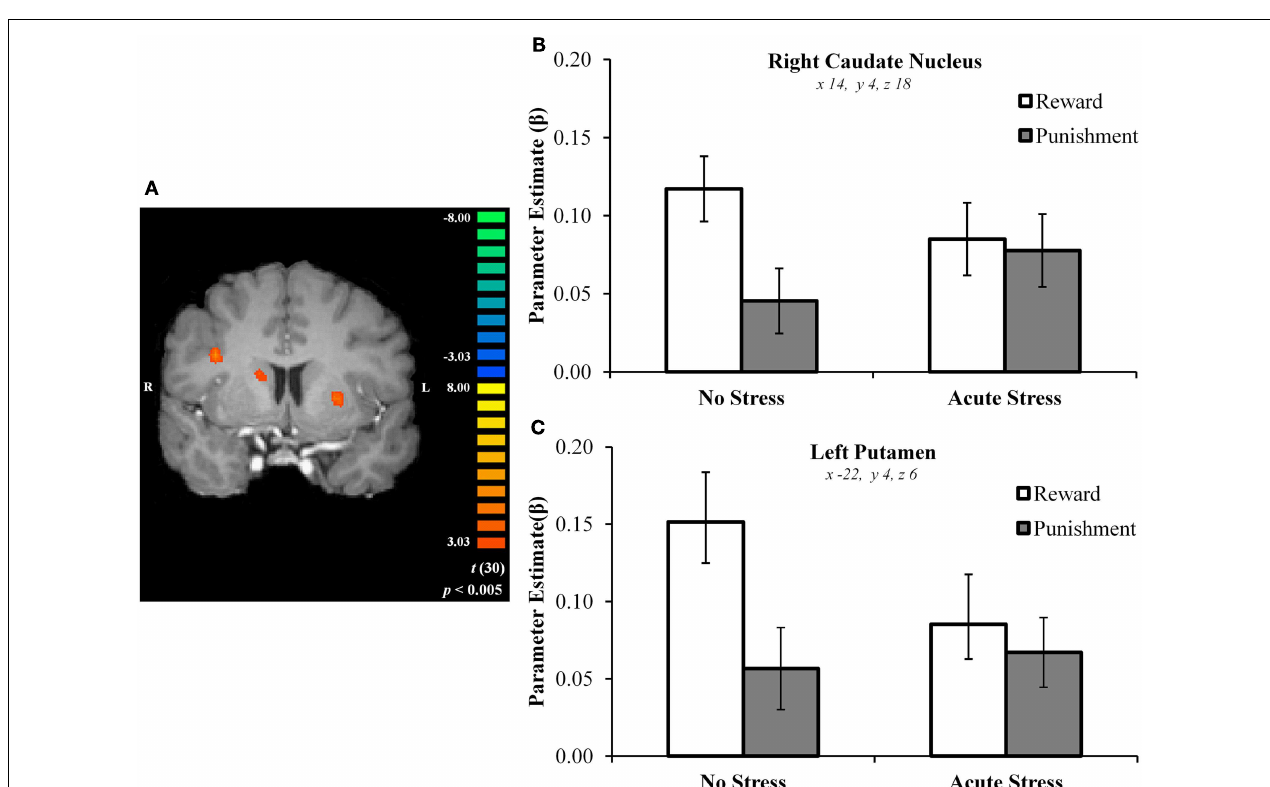
FIGURE 3 | (A) Right caudate and left putamen clusters exhibiting greater BOLD signal for no stress over acute stress participants. (B) Right caudate nucleus outcome valence × experimental group parameter estimates. (C) Left putamen outcome valence × experimental group parameter estimates.